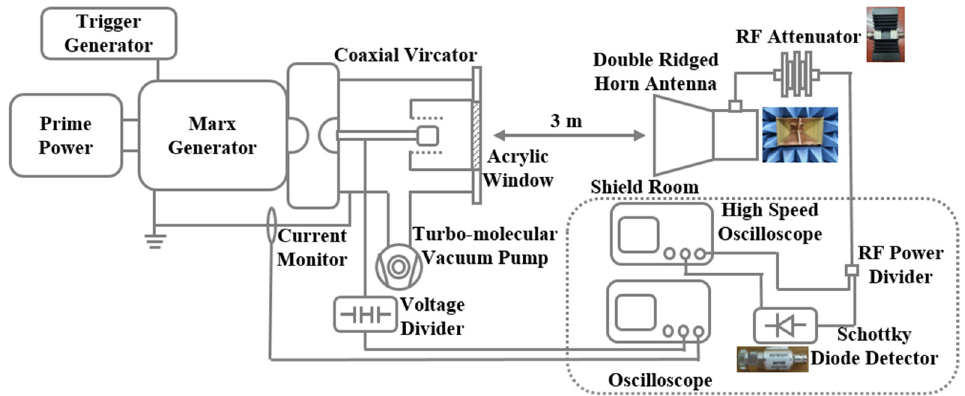
Figure 1. Schematic diagram of the experimental HPM system.